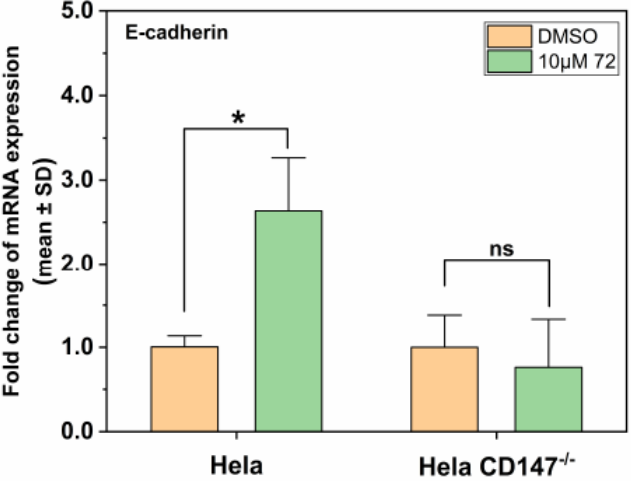
Figure 6. Effect of compound 72 on the mRNA expression of E-cadherin in Hela and Hela CD147 knockout cells (mean ± SD, standard deviation was calculated with three replicates). * p < 0.05, ns indicates p > 0.05.